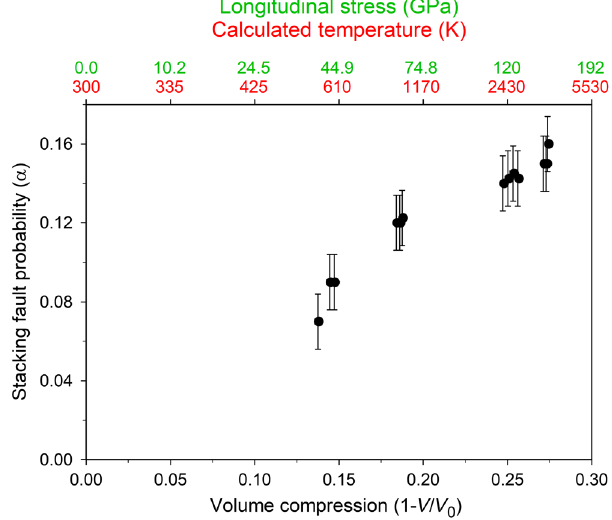
FIG. 4. Stacking-fault probability versus volume compression. Stacking-fault probability α increases monotonically with vol- ume compression. Corresponding longitudinal stresses and cal- culated temperatures are shown at the top. The calculated temperatures are determined using the equation of state from Ref. [17]. At the lowest stresses ( ∼ 40 GPa), and as discussed in the SM [41], potential contributions of strength effects on the stacking-fault probabilities cannot be ruled